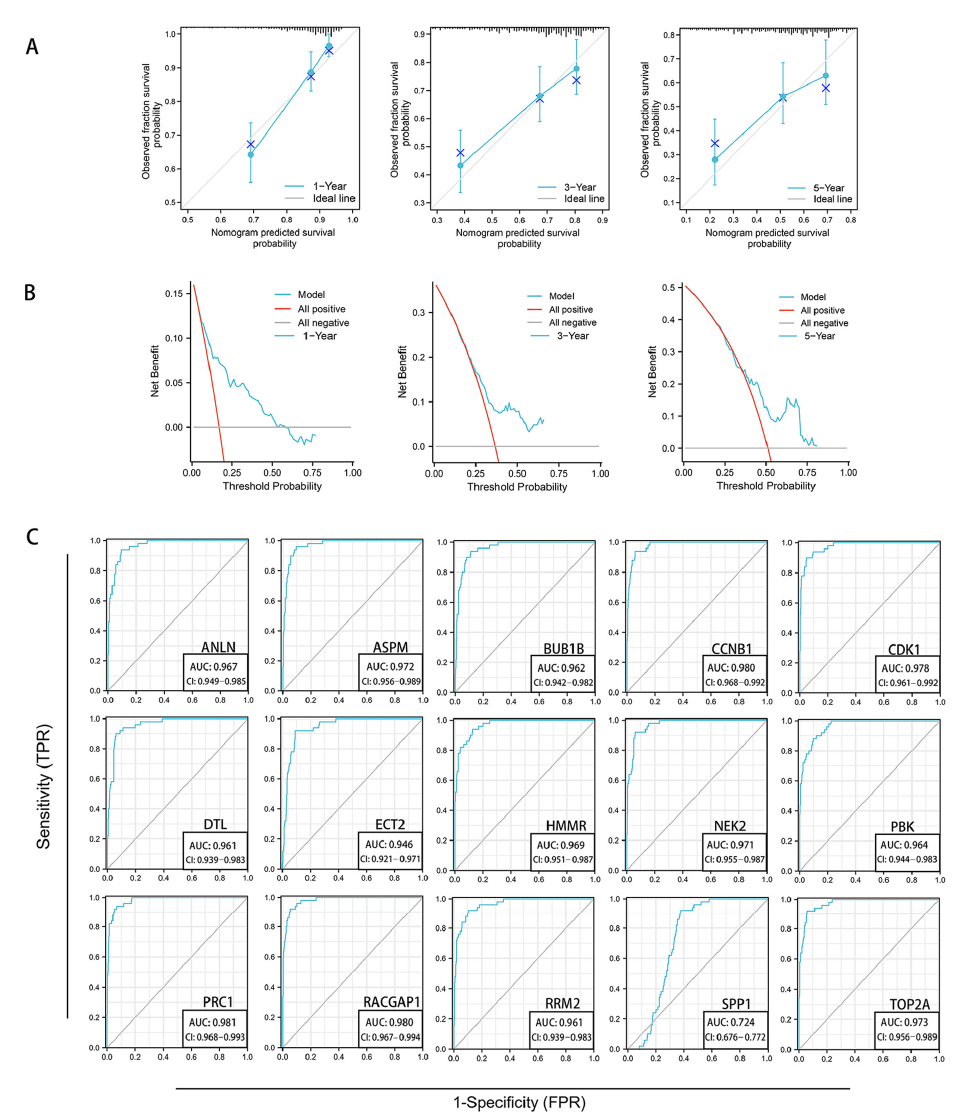
Figure 8. Assessment of precision, sensitivity, and clinical utility of the predictive model. ( A ) Calibration curve for predicting the probability of 1-, 3-, and 5-year OS for patients with HCC. Calibration curve of the nomogram in HCC from TCGA data. ( B ) DCA plots of the nomogram by calculating the C-index. ( C ) ROC curve analysis of 15 up-regulated hub genes to distinguish HBV-related HCC tissues from normal tissues. ROC, receiver operating characteristic; DCA, decision curve analysis.